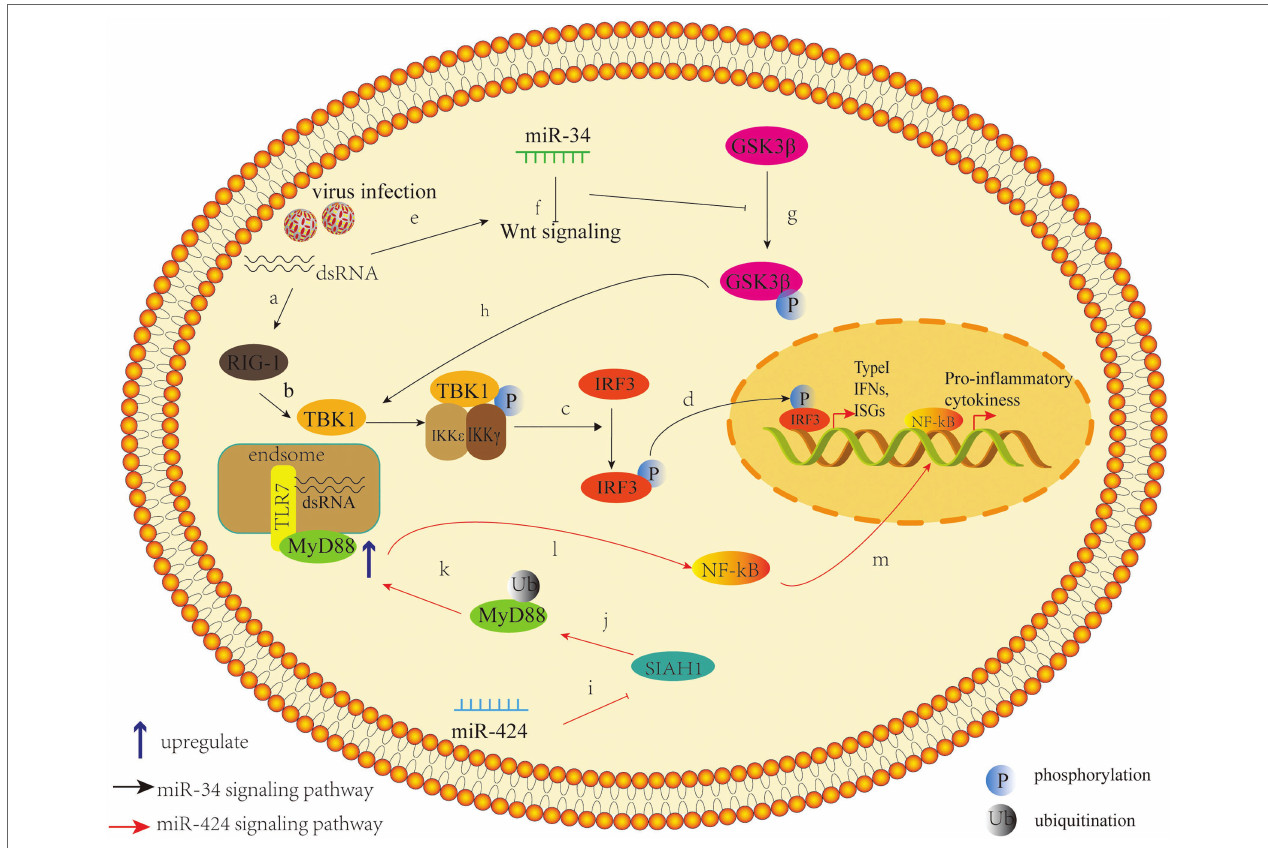
FIGURE 2 | Pattern of miR-34 (the black arrow) and miR-424 (the red arrow) that inhibit or promote DENV replication by regulating host factors. (a) The induction of the innate response by virus infection or other stimuli through pattern recognition/retinoic acid inducible gene I (RIG-I)-like receptors. (b)Viral infection leads to activation of innate immunity and first induces phosphorylation of TANK-binding kinase 1 (TBK1). (c) This is followed by the phosphorylation or homodimerization of the interferon regulatory factor 3 (IRF3), (d) and then it translocated into the nucleus, where it induces the transcription of type I Interferons (IFNs) and interferon- stimulated genes. (e) Meanwhile, the viral infection also activate the Wnt signaling pathway, (f) leading to the repression of the Glycogen synthase kinase 3 beta (GS3K β ) phosphorylation, and (g) which suppresses the IFN pathway by interacting with TBK1. The intersection between these two pathways suggests that the Wnt signaling pathway has the ability to modulate the innate inflammatory response. (h) miR-34 can act as an inhibitor of the Wnt signaling pathway to enhance type I IFN signaling, leading to a cellular antiviral status (Smith et al., 2017). (i) miR-424 suppresses expression of the E3 ubiquitin ligase SIAH1; (j) SIAH1 binds to and ubiquitinates the innate immune adaptor protein MyD88; (k) SIAH1 knockdown inhibits proteasome-dependent degradation of MyD88; (l) Inhibition of SIAH1 increases MyD88-Mediated NF-kB signaling during DENV2 infection; (m) and further promote the production of the NF-kB–activated proinflammatory